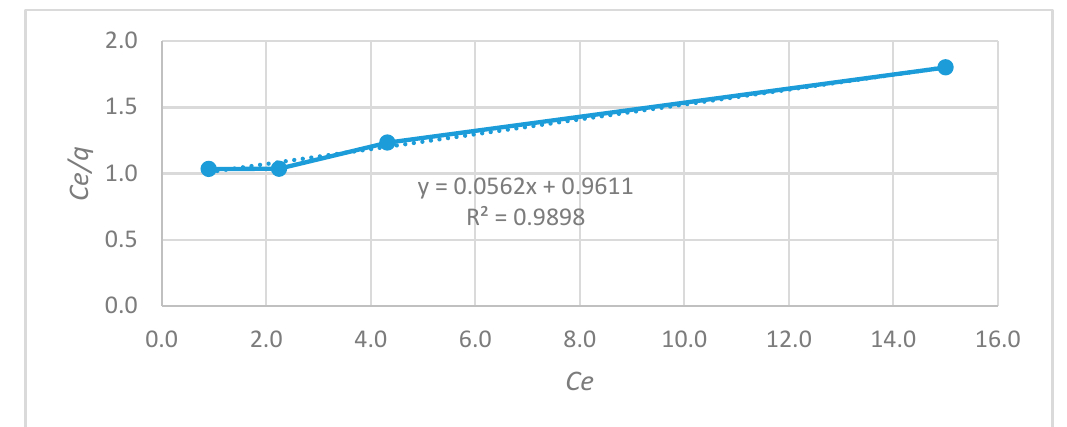
Figure 4. Langmuir isotherm EC.